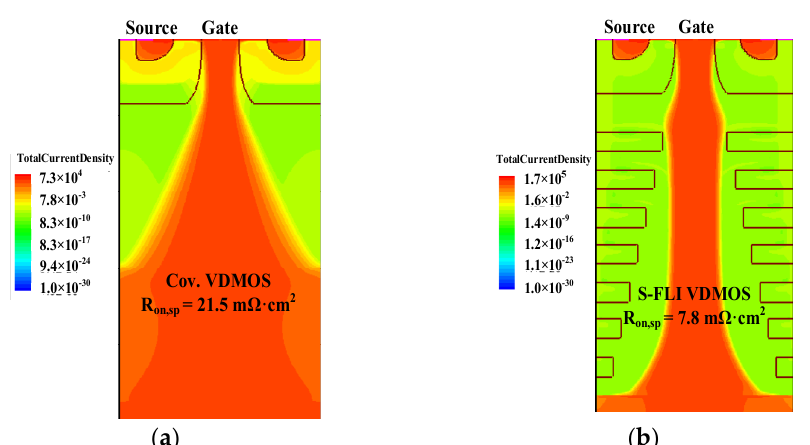
Figure 6. The distribution and flowing paths of total current for the ( a ) conventional Si VDMOS and ( b ) S-FLI VDMOS in on-state.